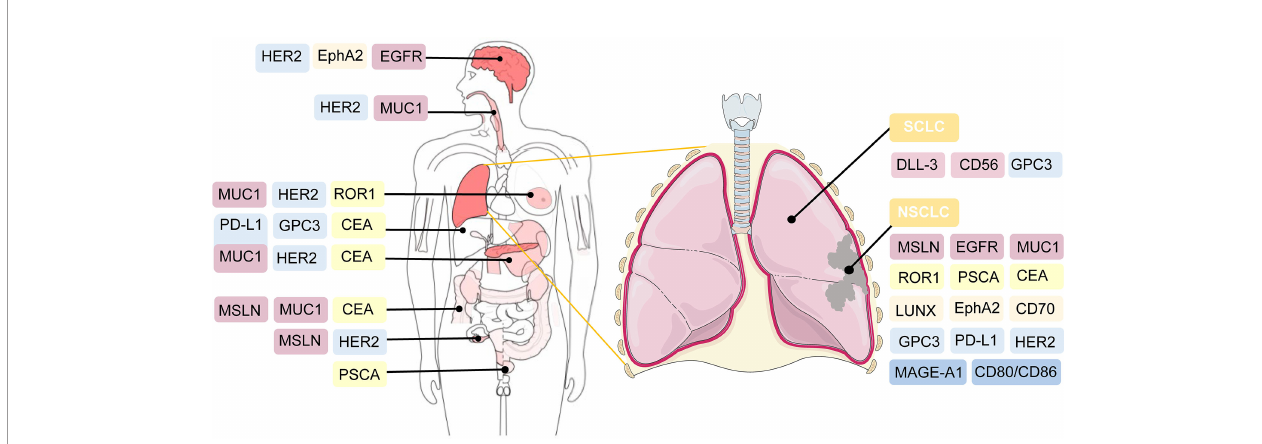
FIGURE 3 | Potential targeted antigens for CAR-T cell therapy in preclinical and clinical trials. In the right, antigen targets are listed against SCLC and NSCLC. As shown in the left of the fi gure, these antigens are also broadly applied in CAR-T cell therapy against other solid